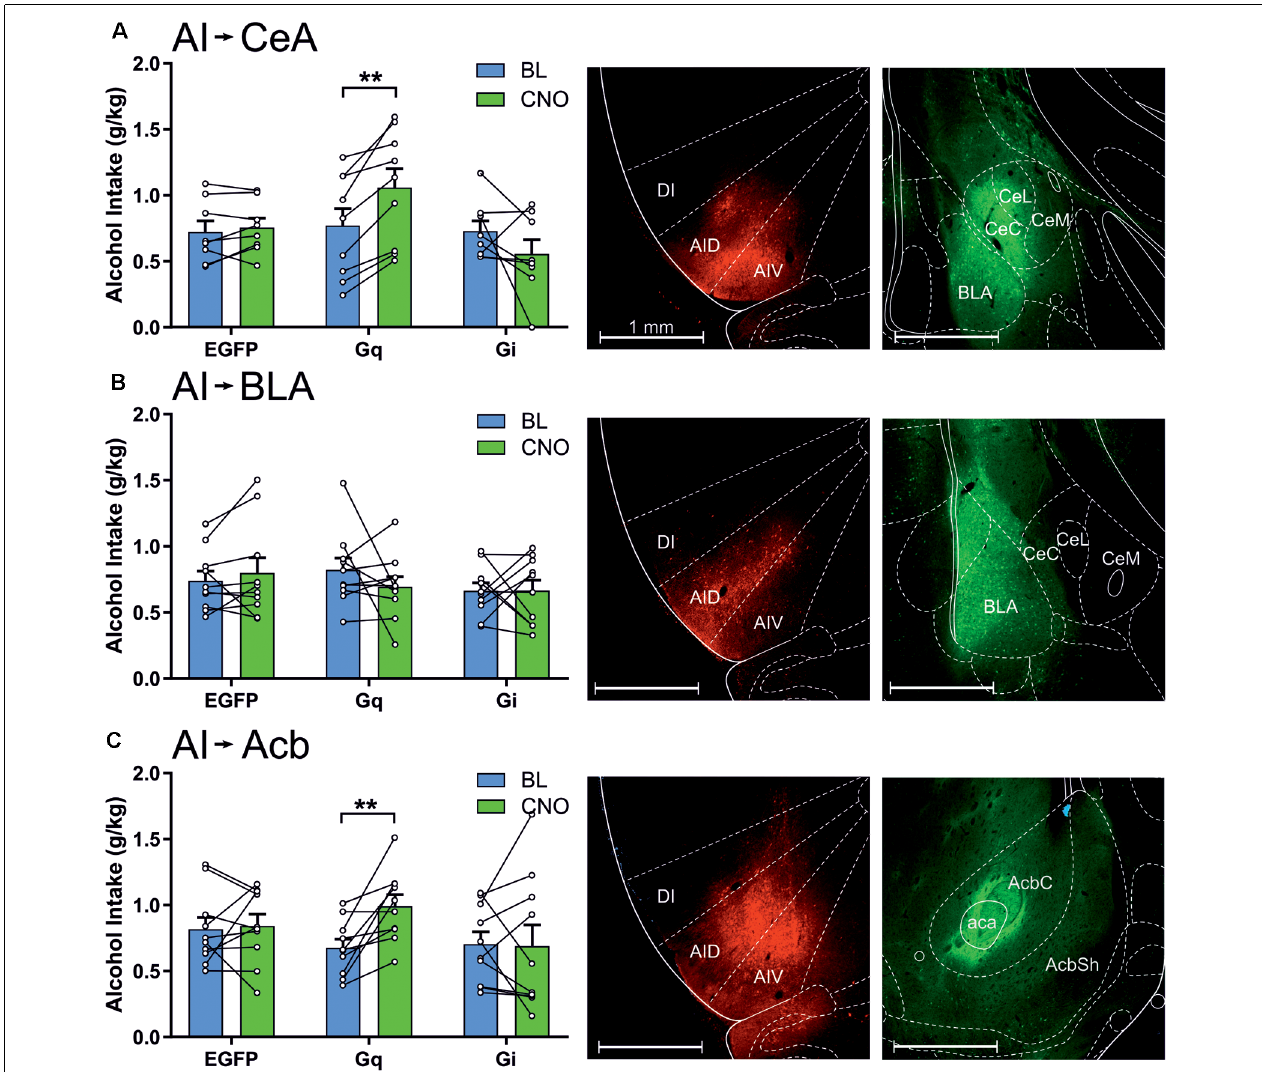
FIGURE 4 | Chemogenetic stimulation of the anterior insula efferents to the central amygdala and nucleus accumbens core increases alcohol drinking. The data are expressed as mean ± SEM alcohol intake (g/kg) during 2-h sessions during the BL and following a CNO injection in three separate treatment groups expressing EGFP, Gq-DREADDs, or Gi-DREADDs in each insula projection. (A) EGFP ( n = 8), Gq-DREADDs ( n = 9), and G-DREADDs ( n = 8) expressed in the anterior insula efferents to the central amygdala. (B) EGFP ( n = 10), Gq-DREADDs ( n = 10), and G-DREADDs ( n = 10) expressed in the insula efferents to the BLA. (C) EGFP ( n = 10), Gq-DREADDs ( n = 10), and G-DREADDs ( n = 10) expressed in the insula efferents to the nucleus accumbens core. Each histogram is accompanied by representative brain sections expressing Gq-DREADD-tagged mCherry reporter in the anterior insula and the AAV2-retro-Cre-tagged GPF in the central amygdala, BLA, and nucleus accumbens core. ** p < 0.01, paired t -tests comparing the BL and CNO sessions. Abbreviations used: DI, dysgranular anterior insula; AID, agranular anterior insula, dorsal; AIV, agranular anterior insula, ventral; CeC, central amygdaloid nucleus, capsular division; CeL, central amygdaloid nucleus,